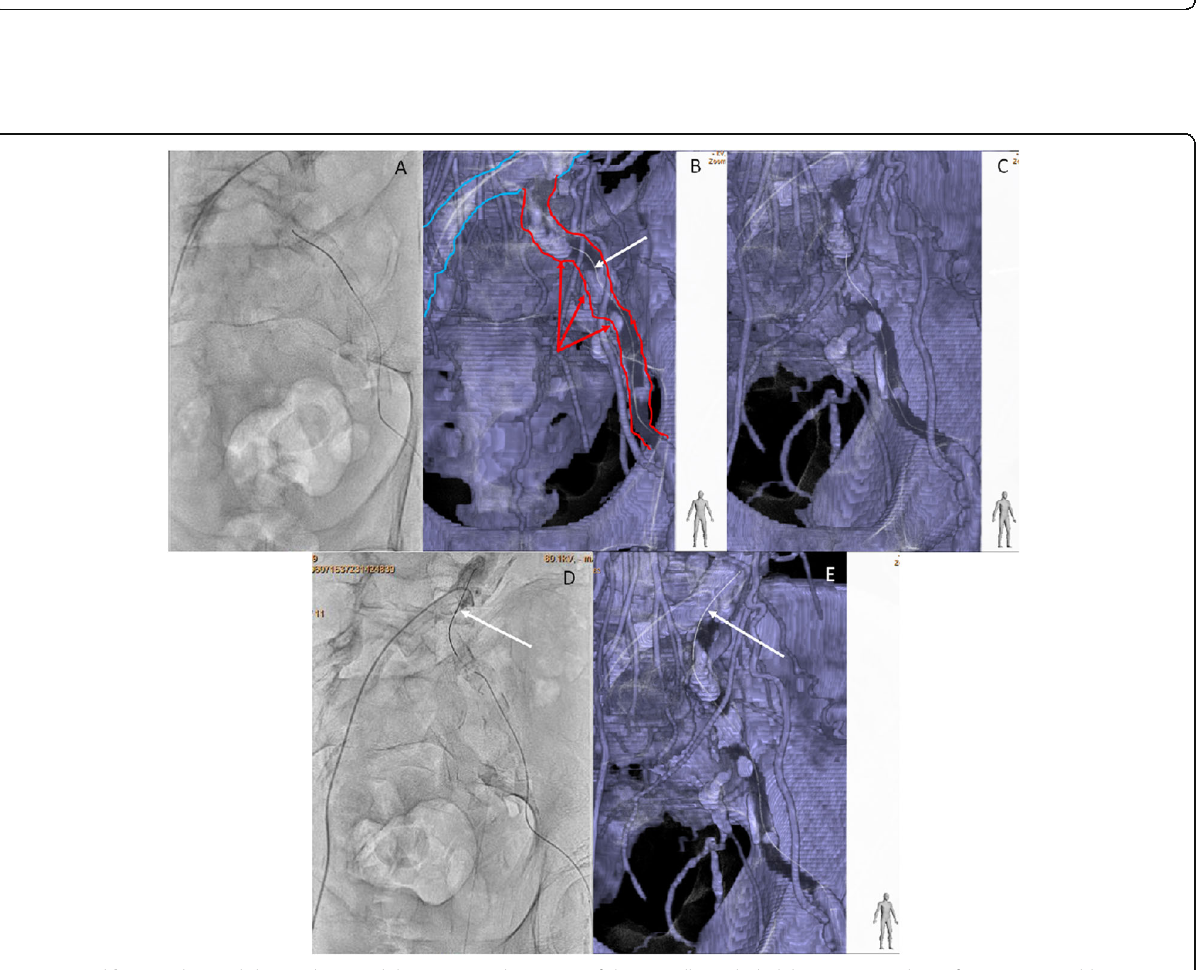
Fig. 2 a : Pre procedural enhanced CT revealed total occlusion from the ostium of the left common iliac artery (CIA) to the distal end of the external iliac artery (EIA) and total occlusion of the left superficial femoral artery. b : Bidirectional control angiography revealed total occlusion from the ostium of the left CIA to the distal aspect of the left EIA. c : This is CTf3D-RM (blue arrow showed opened aorta and right CIA, red arrow showed virtual occluded vessels, white arrow showed guidewire). The control angiography and CTf3D-RM images matched well